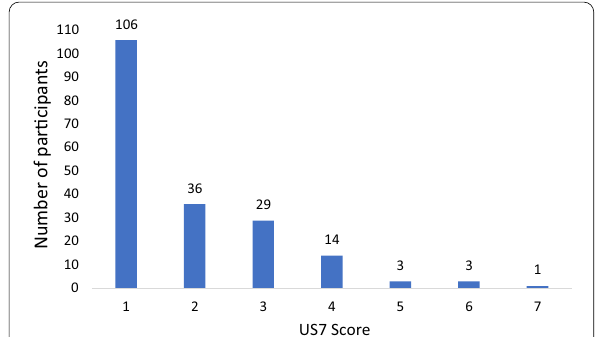
Fig. 3 Grading according to ‘US7 Score’. Grading for inflammatory signs according to the ‘US7’. 192 out of 560 participants showed a score of 1 in the investigated joints. These include the dorsal, ≥ palmar and ulnar wirst, the metacarpophalangeal joints 2, 3 and 5 (MCP-II, MCP-III and MCP-V), as well als the proximal. interphalangeal joints 2 and 3 (PIP-II and III) with were investigated in 560 participants.